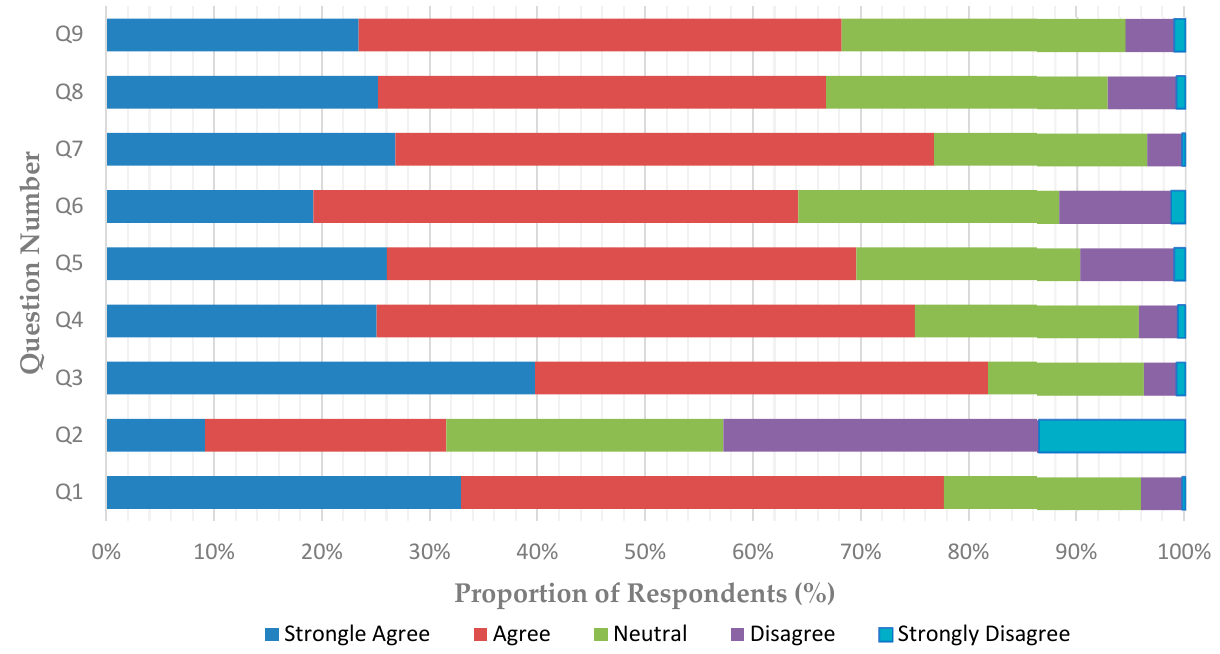
Figure 1. Responses of participants to questions related to attitudes toward teledentistry ( n = 603). Table 3. Responses of participants to attitude-related questions based on qualification and clinical experience ( n = 603).